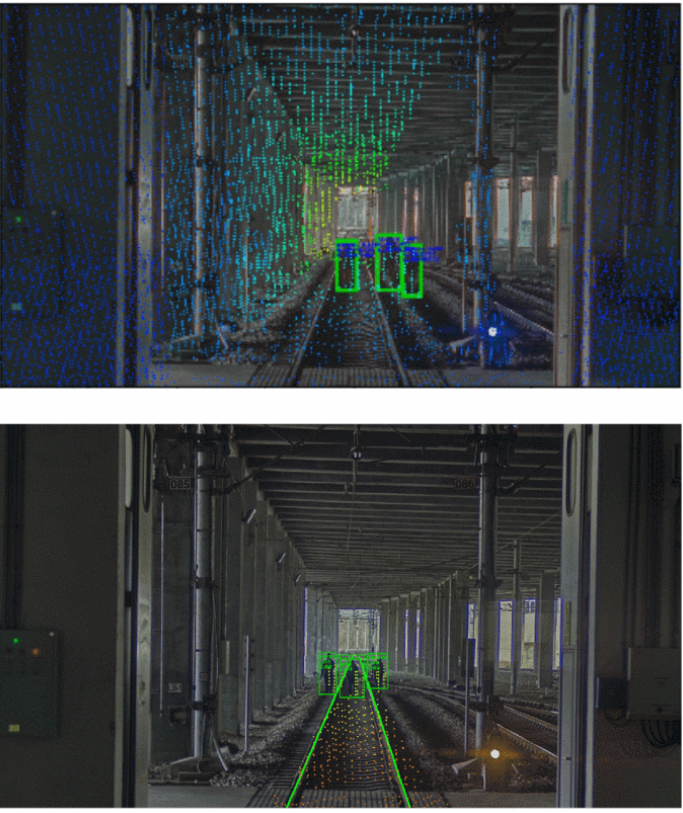
Figure 8. Example of railroad trespassing detection. Reproduced with permission from IEEE